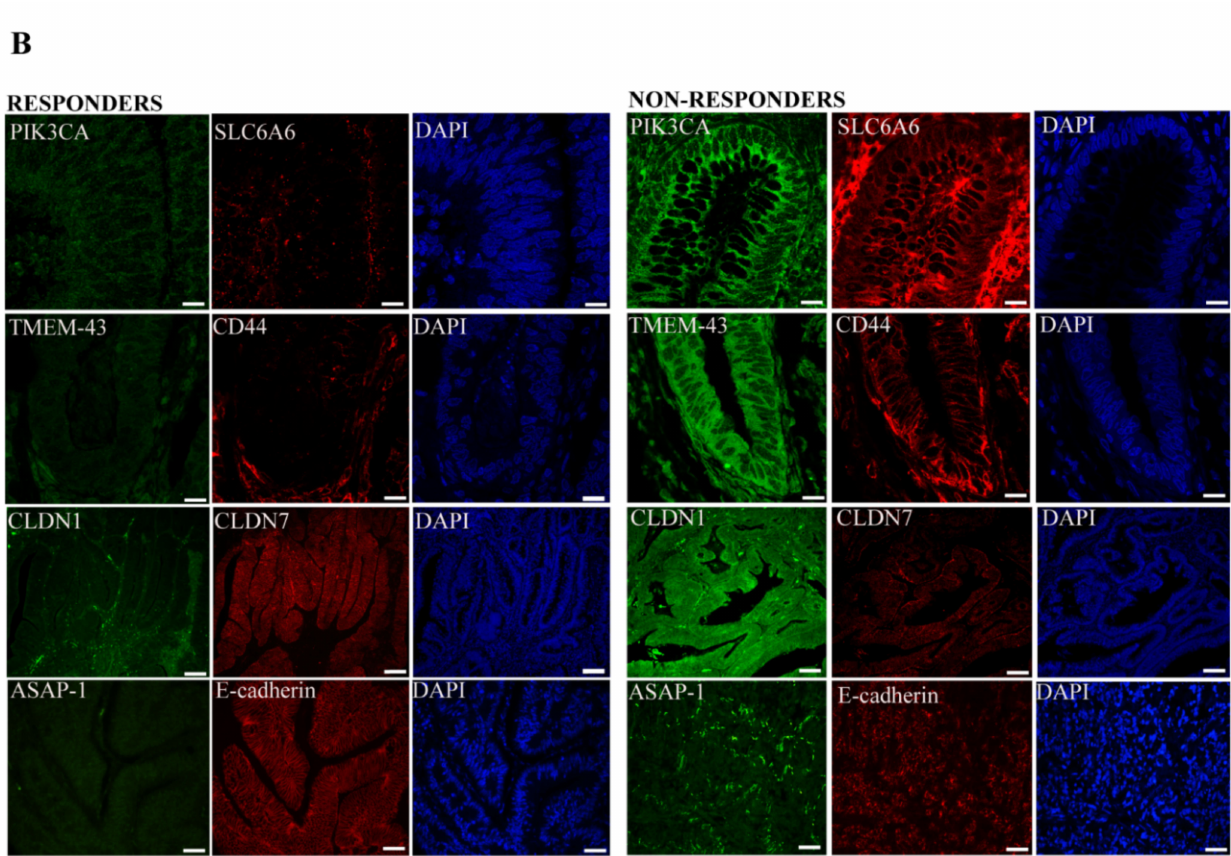
Figure 2. Validation of the genes in responder and non-responder patient samples: ( A ) The transcriptome analysis of PIK3CA, SLC6A6, ASAP-1, TMEM-43, CLDN1, and CLDN7 in nodal colon cancer metastasis datasets from TCGA database through UALCAN; N0- No regional lymph node metastasis, N1- metastasis in 1-3 axillary lymph nodes, N2- metastasis in 4–9 axillary lymph nodes, N3- metastasis in 10 or more axillary lymph nodes. The median value was used to depict the bar graph and the respective ± error values are detailed in Supplementary Table S3. ( B ) The colonic sections from patients who either responded or did not respond to chemotherapy were immunostained with anti-PIK3CA (green), anti-SLC6A6 (red), anti-TMEM-43 (green), anti-CD44 (red), anti-ASAP-1 (green), anti-E-cadherin (red), anti-CLDN1 (green), and anti-CLDN7 (red) antibodies. The sections were counter-stained with the DAPI (blue) nuclear stain (Magnification: 40 × Scale bar: 50 µ m). The stained sections were visualized under confocal microscope using excitation/emission wavelength for DAPI (529 nm/620 nm), FITC (494 nm/525 nm), and Cya-3 (550 nm/570